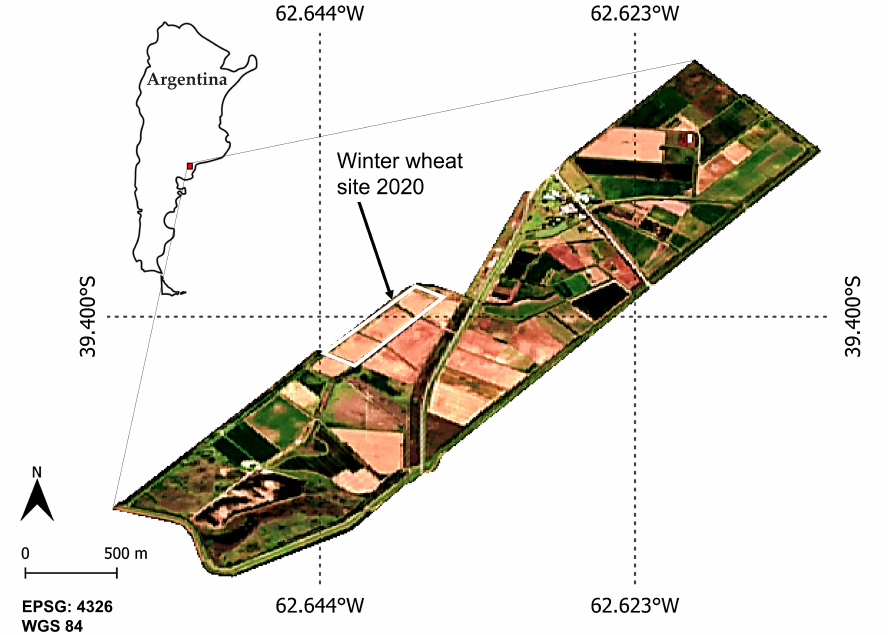
Figure 1. Overview of the Bonaerense Valley of Colorado River study site with test fields for the winter wheat campaign of the year 2020. True colour S2 image (R = B4, G = B3, B = B2) of 27 December 2020. Reference system: WGS84 (EPSG